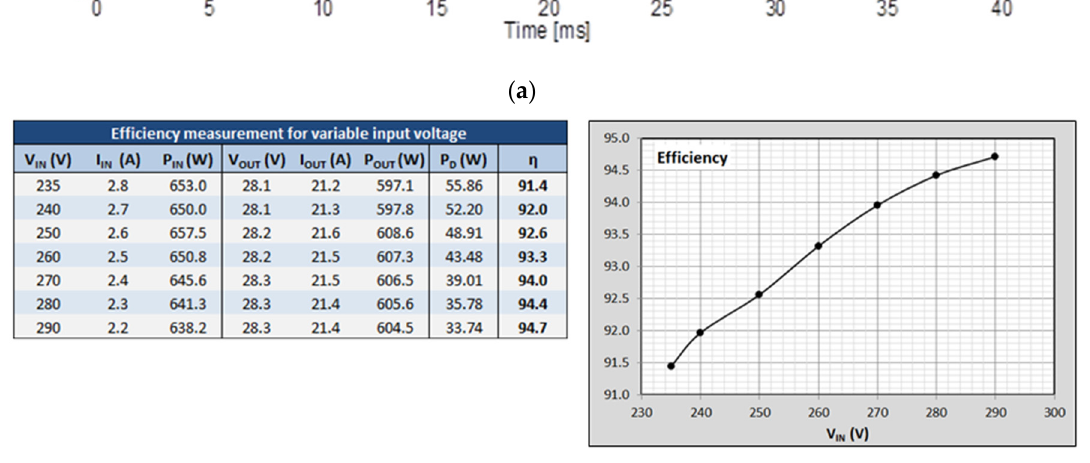
Figure 10. In ( a ), transformer primary and secondary voltage waveforms (top) and series inductor current (bottom); in ( b ), efficiency and detail of average voltage and current values.